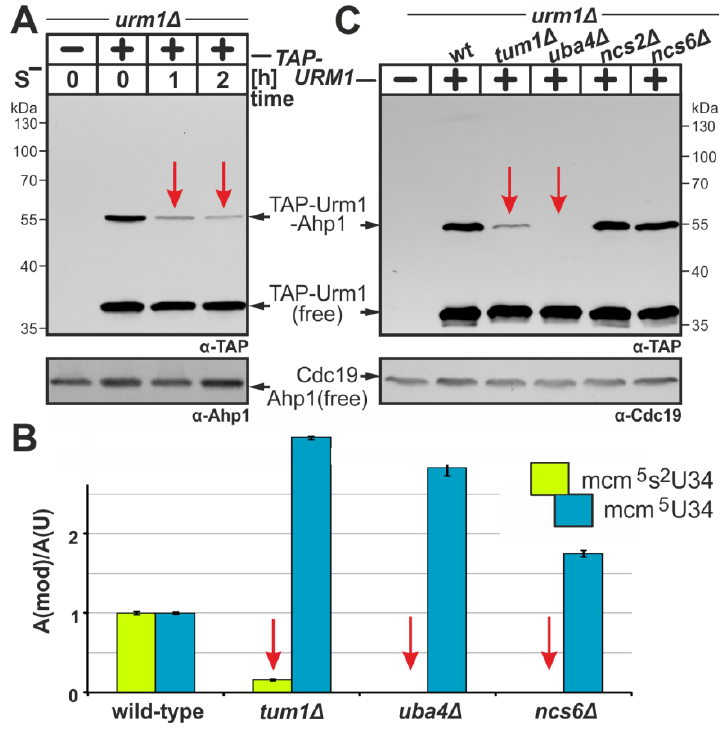
FIGURE 3: Sulfur supply, transfer and activation are critical for the tRNA thiolation and urmylation branches of the URM1 pathway. (A) Urmylation is sulfur sensitive. TAP-URM1 expressing cells (see Fig. 2) were grown in Met containing media prior to S- starvation (S - ) for two hours (h) in media without Met. Analysis of Ahp1 urmylation was as described (see Fig. 2). (B) LC-MS/MS-based tRNA (thio)modification analysis of modified U34 nucleo- side content in tRNAs from wild-type and indicated URM1 pathway mutants. In each case, the modified nucleoside signal was normalized using total uridine content to allow comparison of the different sam- ples. Inset: mcm 5 (blue) and mcm 5 s 2 (green) modifi- cations at U34. (C) Urmylation of Ahp1 is normal in thiolase-minus ( ncs2 ∆, ncs6 ∆) cells but drastically reduced in the absence of S-transferase Tum1 ( tum1 ∆). Protein extracts from TAP-URM1 ex- pressors of the indicated backgrounds (i.e. wild-type (wt) and URM1 pathway mutants) were subjected to Ahp1 urmylation assays as described (see Fig. 2). Non-conjugated (free) forms of TAP-Urm1 and Ahp1 as well as TAP-Urm1 conjugated to Ahp1 and loading control Cdc19 are indicated by arrows (A,